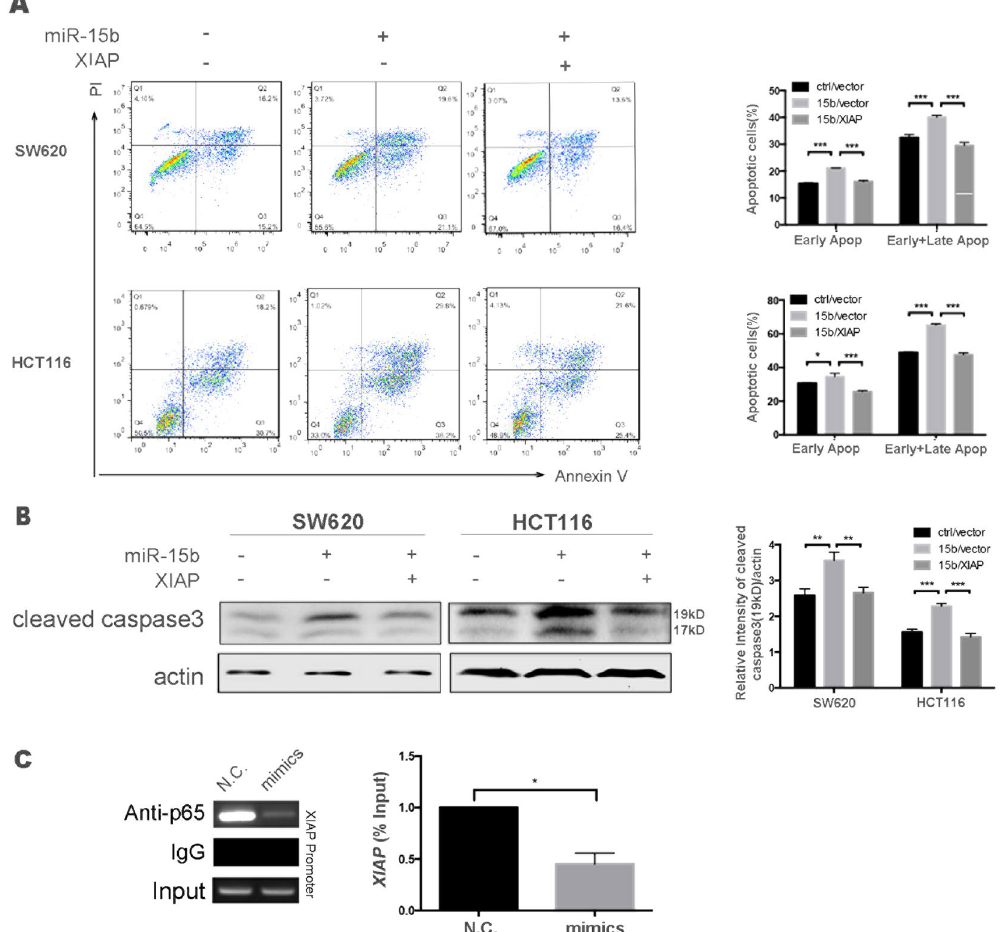
Figure 5. Overexpression of XIAP abolishes miR-15b-5p-induced apoptosis of colon cancer cells and drug sensitivity. ( A ) Flow cytometry analysis showed that the reintroduction of XIAP reduced the sensitivity of miR- 15b-5p to 5-FU to apoptosis. ( B ) Western blot analysis of cleaved caspase 3 protein levels after XIAP or miR- 15b-5p were co-transfected into HCT116 and SW620 cells. ( C ) ChIP assay was performed by using HEK293T cells. Chromatin was immunoprecipitated by using p65 specific antibody. Regular PCR was carried out by using primers of XIAP